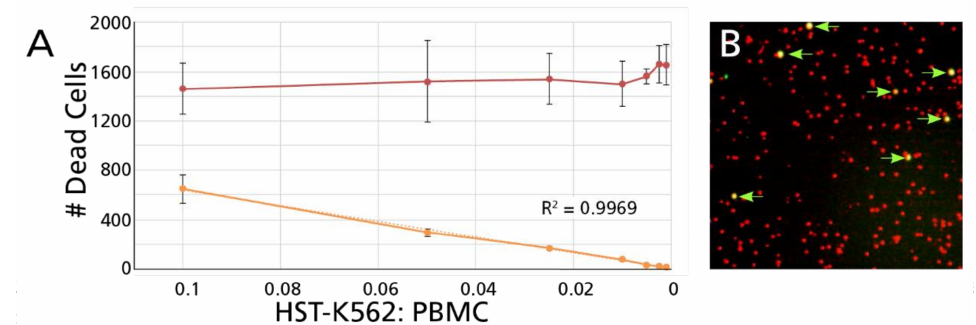
Figure 6. Detection of individual dead K562 target cells within an excess of live and dead PBMC